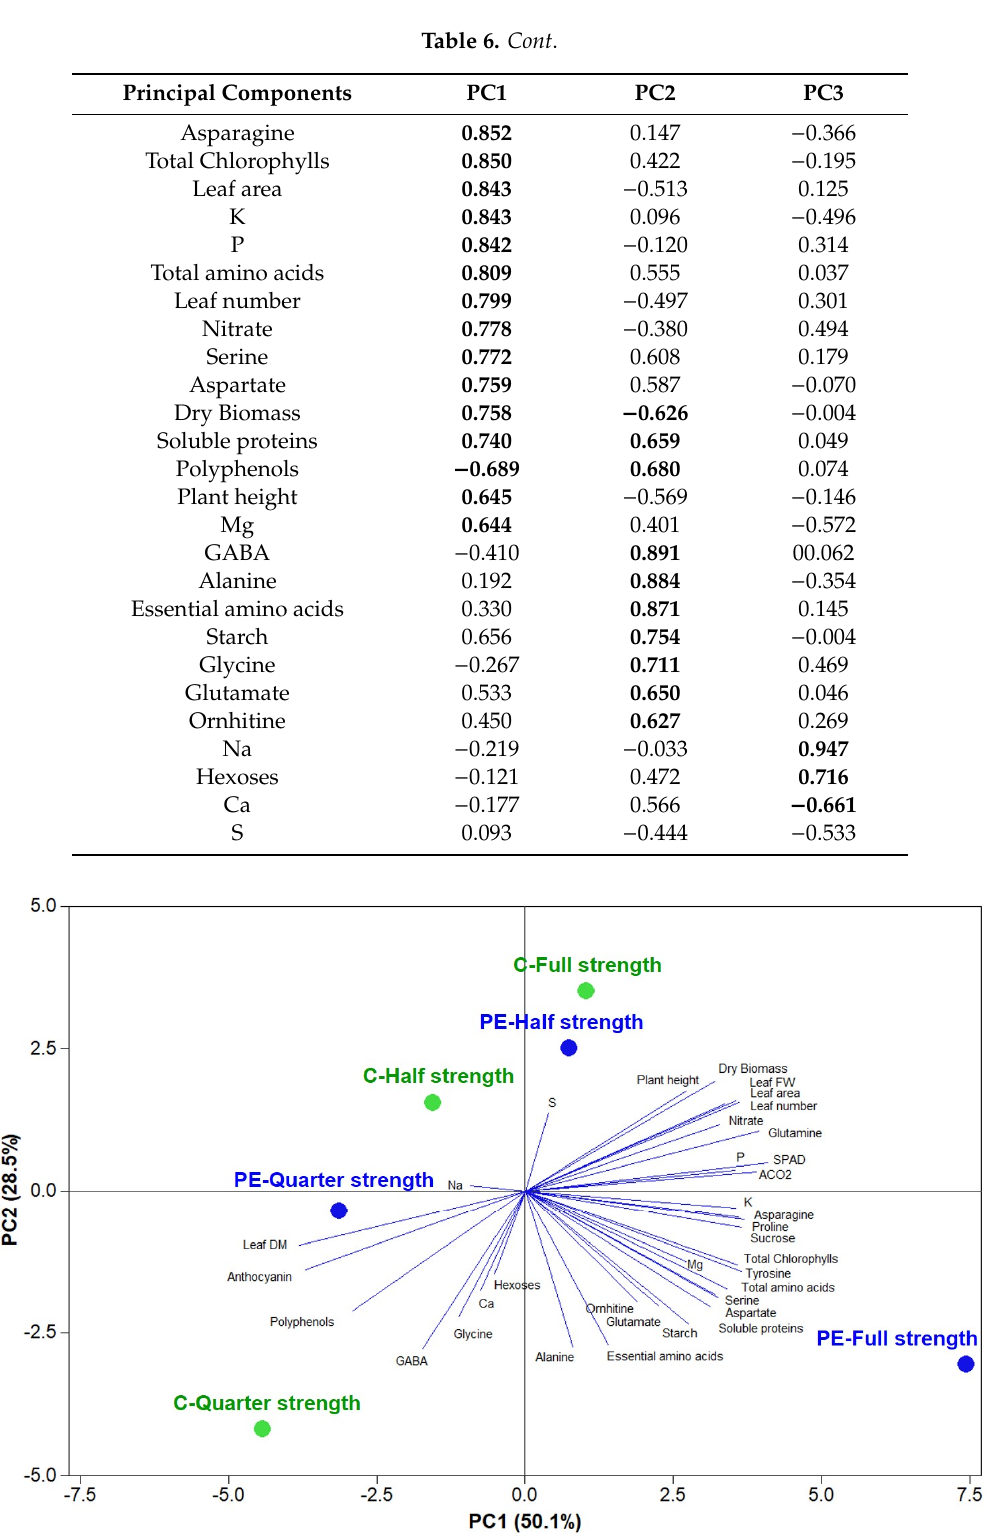
Figure 3. Principal component loading plot and scores of principal component analysis (PCA) of growth parameters, fresh yield, and shoot dry biomass mineral concentrations (nitrate, P, K, Ca, Mg, S, and Na), net CO 2 assimilation rate (A CO2 ), SPAD index, chlorophyll, starch, soluble carbohydrates, soluble proteins, amino acids profile, and total amino acids in untreated (C) and treated Corchorus olitorius plants with tropical plant extract (PE) biostimulant grown under different nutrient solution concentration (full-, half-, and quarter-strength: 100%, 50%, and 25%, respectively).